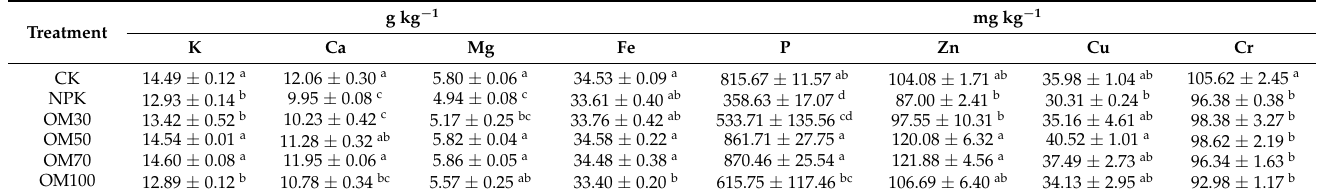
Table 6. The total elements of soil treated with different fertilizers (mean ± standard